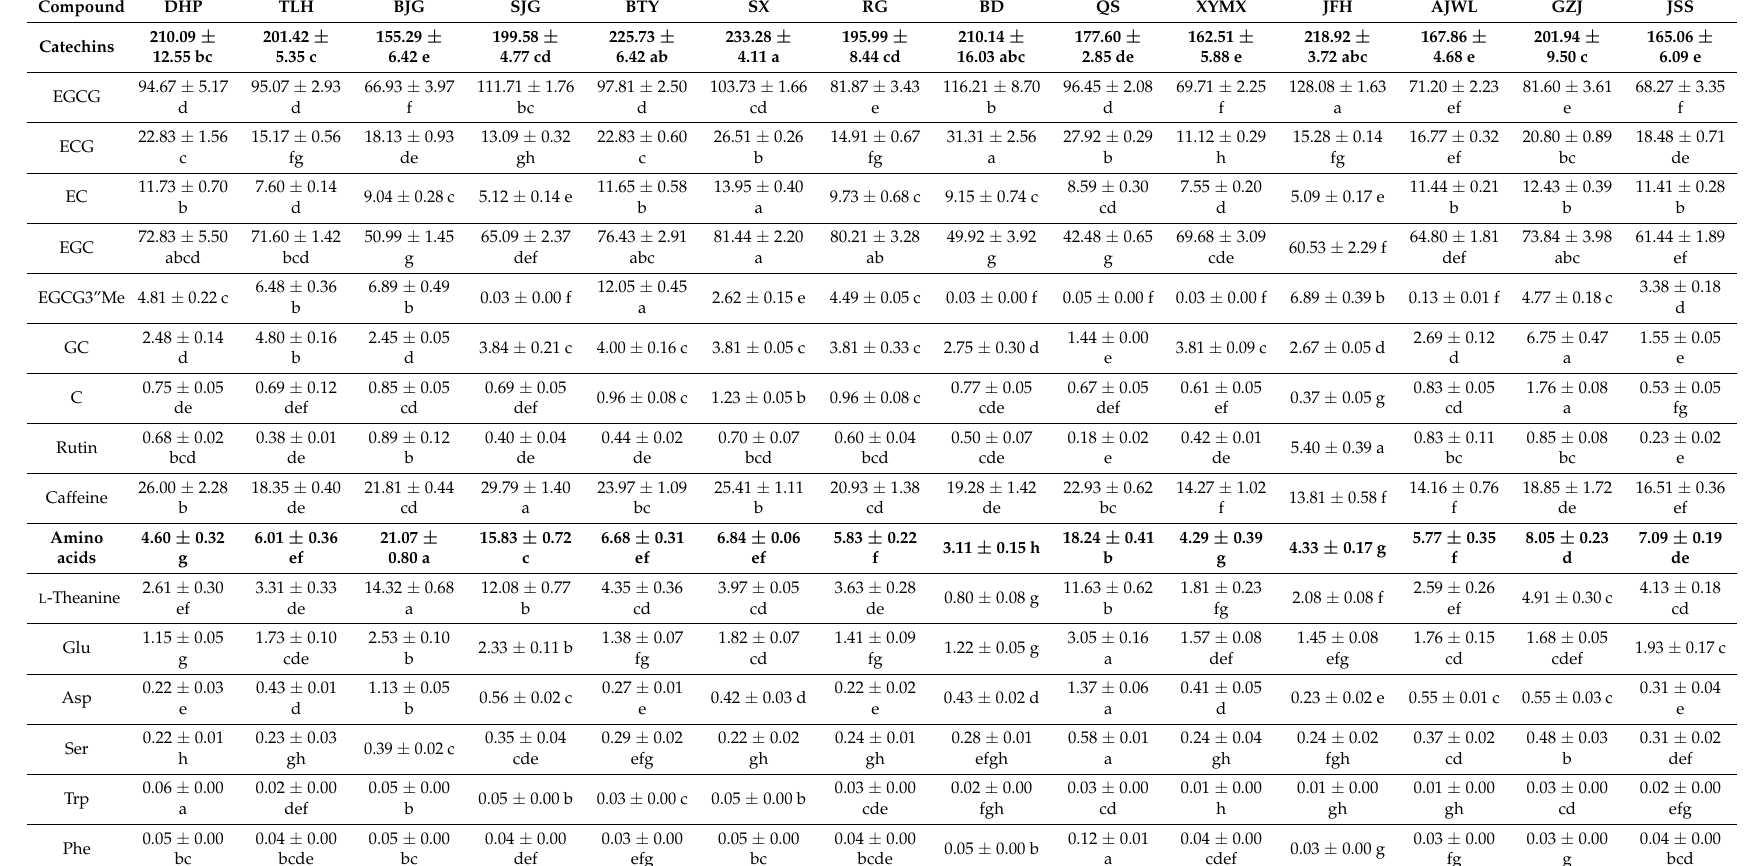
Table 2. Abundance (mg/g DW) of catechins, rutin, caffeine and amino acids in tea leaves in relation to